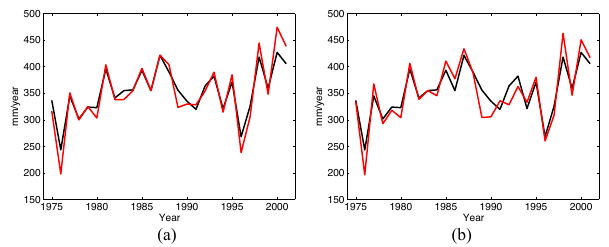
Figure 9. Yearly discharge from the gauged basin area (black) and extrapolated discharge 3 Fig. 9. Yearly discharge from the gauged basin area (black) and ex- (red) using selected source-cells from example 1 (a) and example 2 (b). 4 trapolated discharge (red) using selected source cells from example 1 (a) and example 2 (b) .